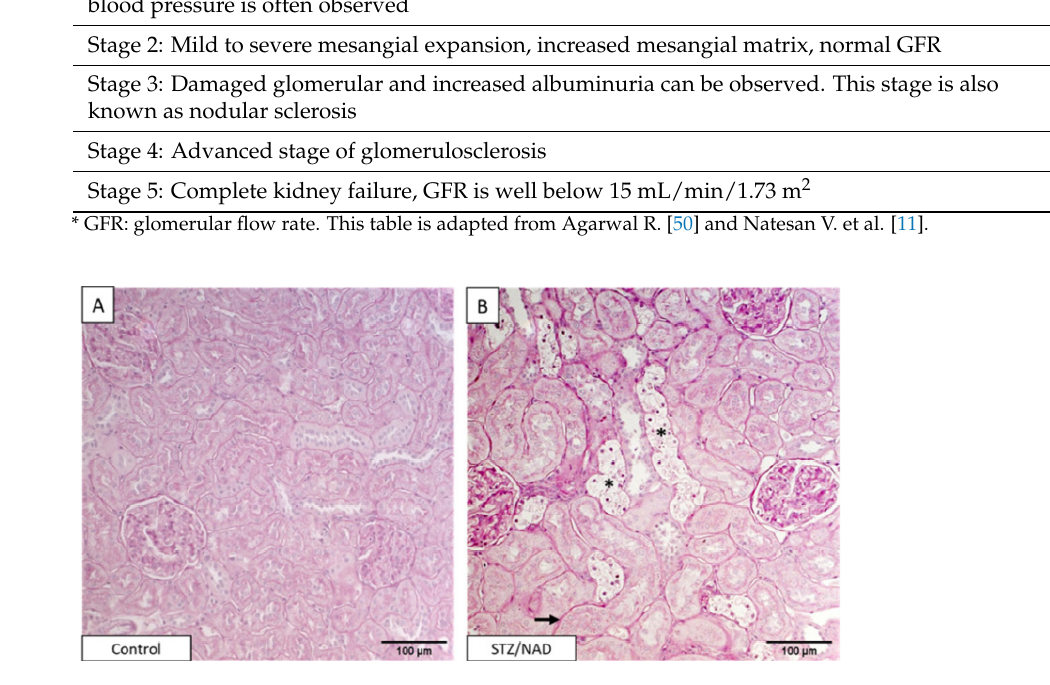
Figure 3. Histopathology staining of DN. Periodic acid–Schiff (PAS)-stained renal sections of a non- diabetic control rat ( A ) and STZ/NAD ( B ) diabetic rat at week 12. Indicated are tubular epithelial cell necrosis (asterisk), thickening of tubular basement membrane (arrow). This figure was reproduced from Corremans et al. [48].